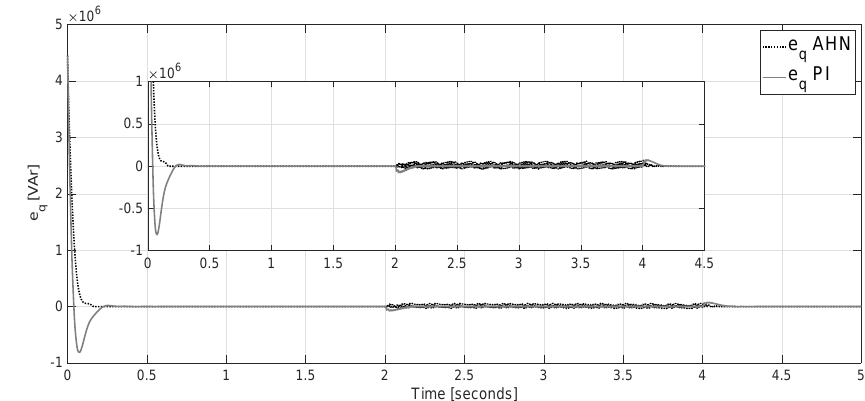
Figure 18. Simulation of the regulation error e q of reactive power during Test